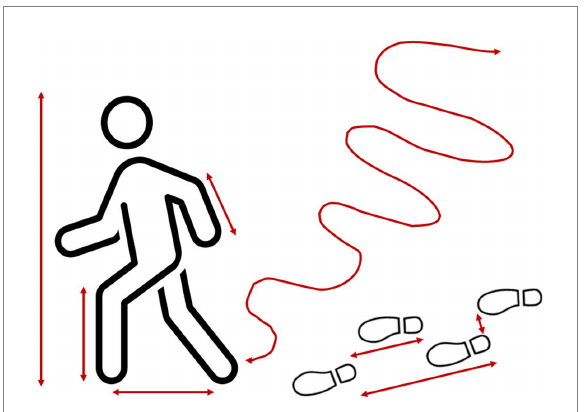
FIGURE 7 Measurands in individuals. Measurands are the specific entities to be measured; their unknown quantity is to be determined through measurement. Scientists must specify which particular entity of a target property (e.g., length) is the measurand in a study. For example, one cannot “measure an individual’s length” per se but only the specific entities of length that it may feature, such as the length of its body height, left lower leg, left forearm, stride, step, distance walked per hour, etc. In rating-based research, by contrast, psychologists often specify just the researchee in general as the entity to be studied (e.g., “measure an individual’s level of ‘activity’”)—a reflection of the inherently conceptual level of consideration